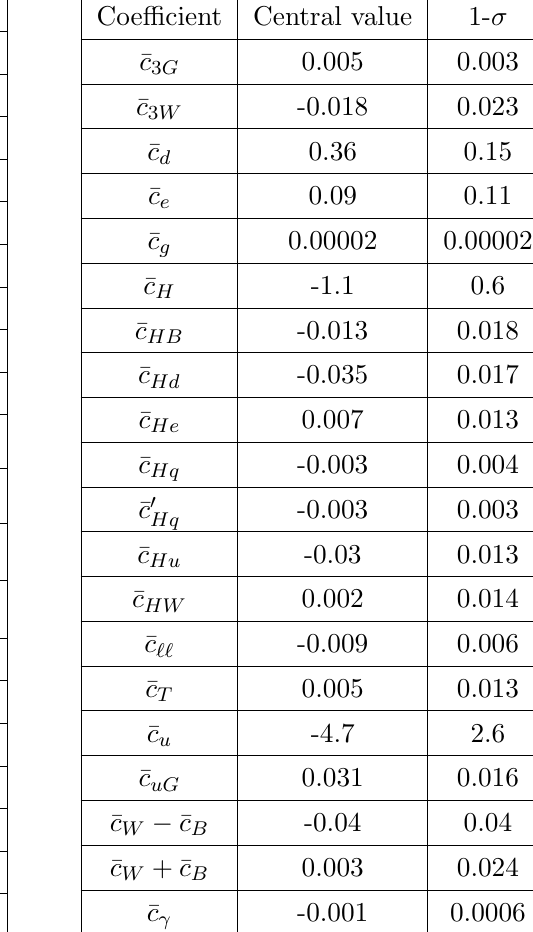
Table 4. Numerical results of a global (cid:12)t to all data, marginalizing over all coe(cid:14)cients, evaluated in the Warsaw (left) and SILH (right)